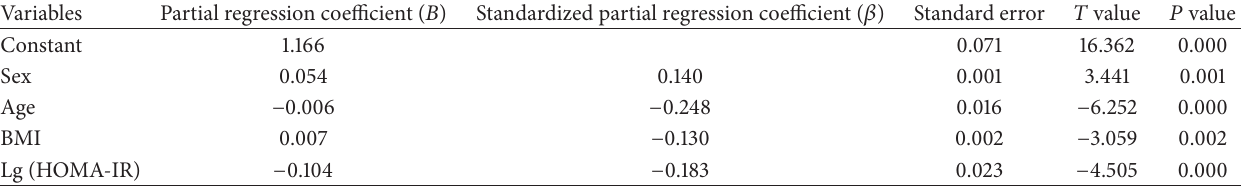
Table 3: The variables entering into the multivariate linear regression